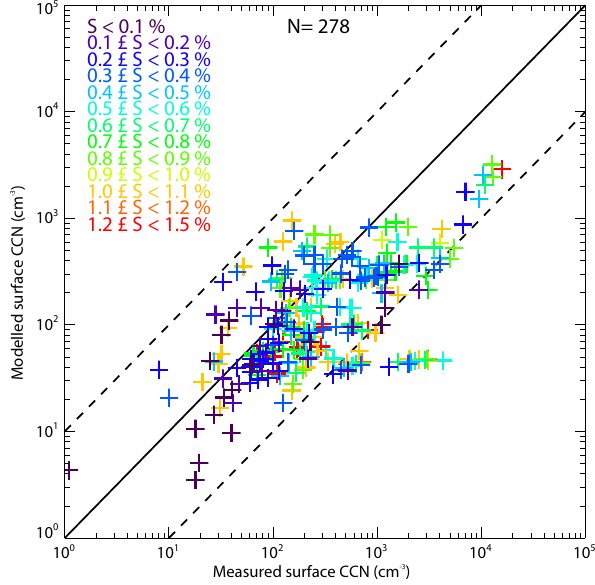
Figure 1. CCN measurements from 55 studies, versus co-located modelled monthly mean surface concentration of CCN at the same supersaturation and location. Points are coloured by supersatura-